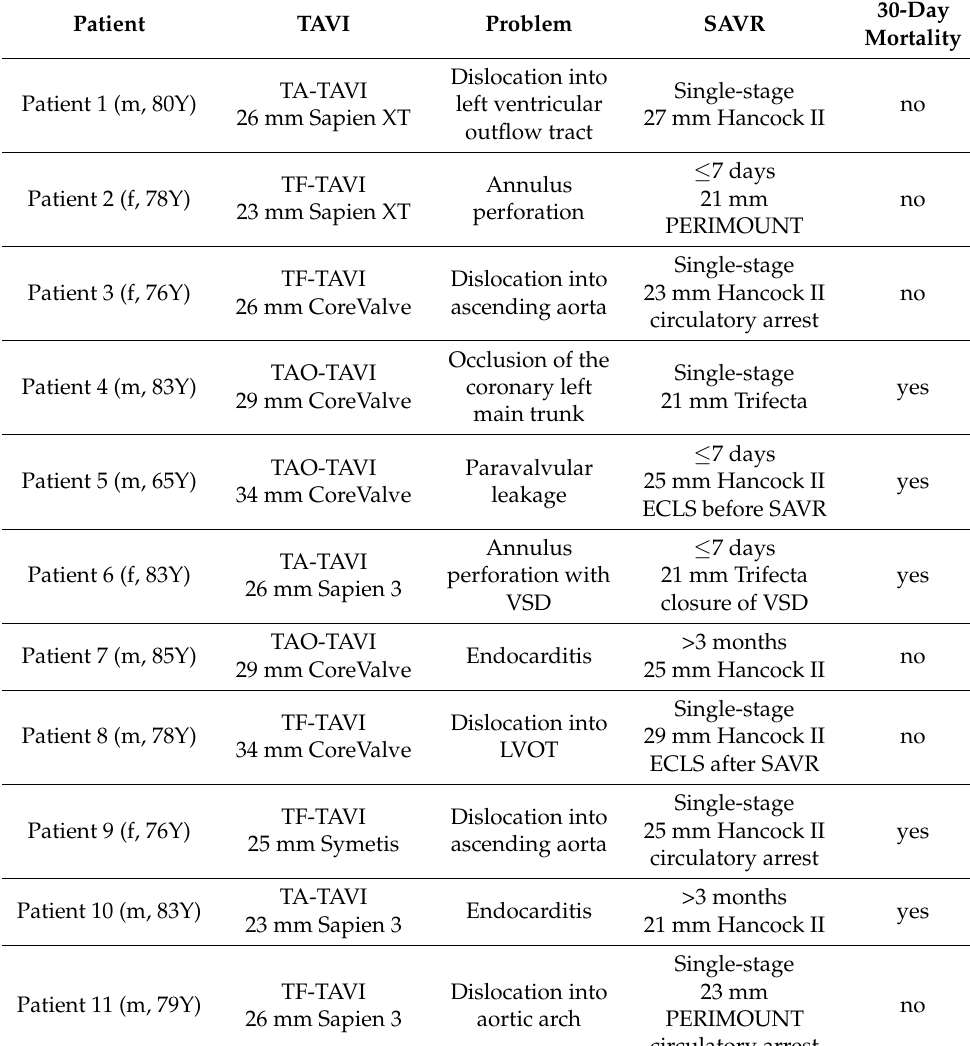
Table 4. Core Data and Indications for